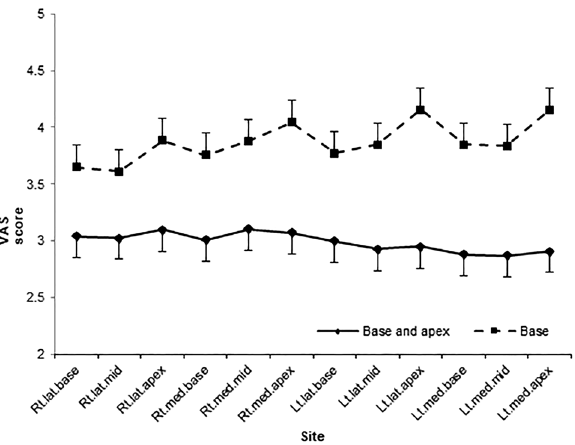
Figure 1. Mean profile plot of VAS scores for each SBx. SBx systemic prostate biopsy, Lat lateral, Lt left, Med medial, Rt right, VAS visual analog scale.